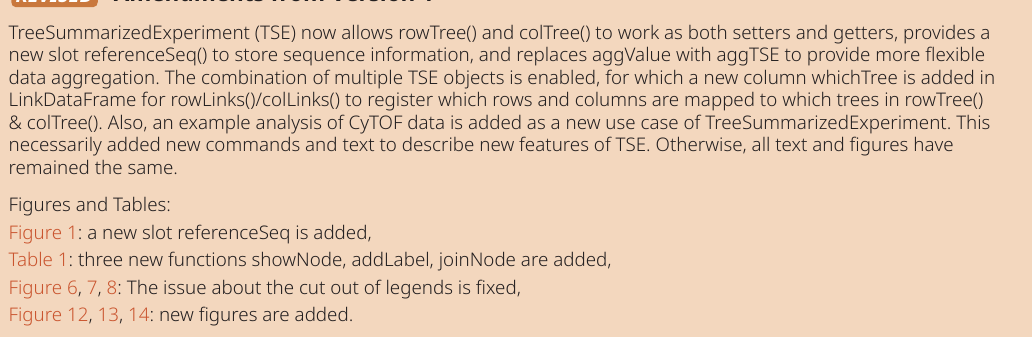
Figure 1: a new slot referenceSeq is added, Table 1: three new functions showNode, addLabel, joinNode are added, Figure 6, 7, 8 : The issue about the cut out of legends is fixed, Figure 12, 13, 14 : new figures are